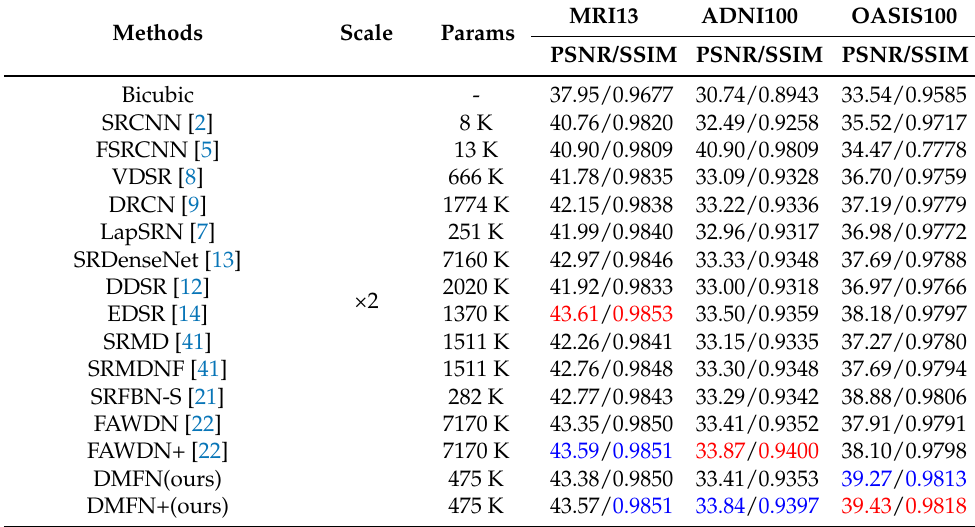
Table 6. Comparison of PSNR/SSIM for differentscale factors on the MRI13 [22], ADNI100 [36], and OASIS100 [37] datasets. The red and blue represent the best and second-best results,